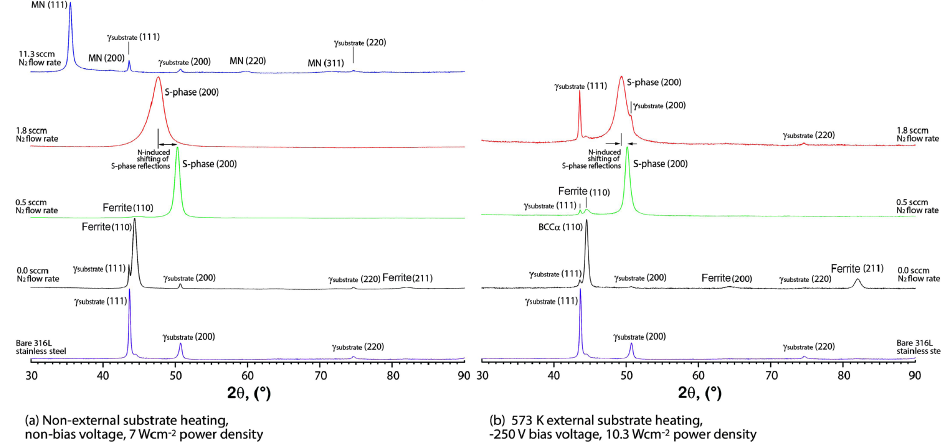
Figure 3. Effects of sputtering conditions on the XRD